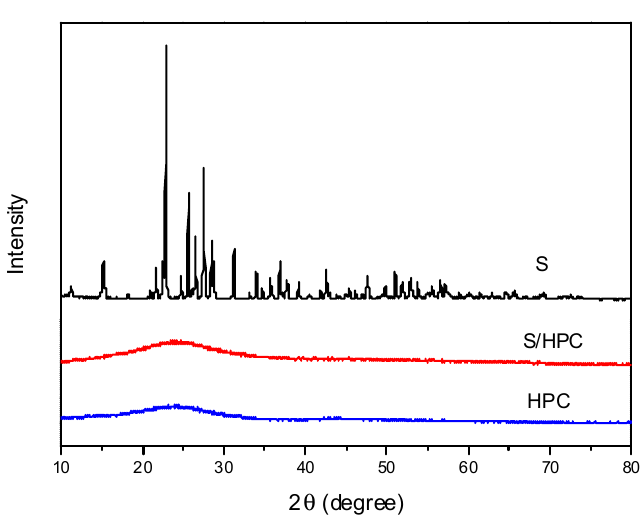
Figure 1. XRD patterns of S, HPC and S/HPC composite.